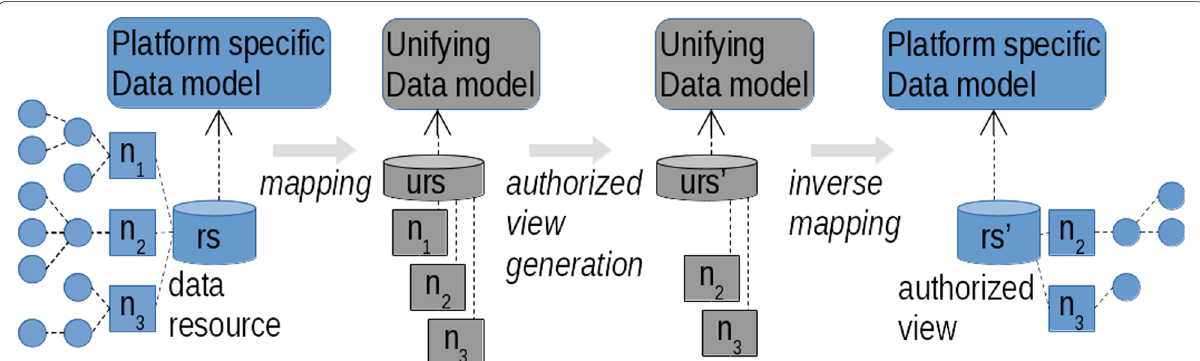
Fig. 1 The pipeline of operations at the basis of an enforcement mechanism leveraging on the unifying data